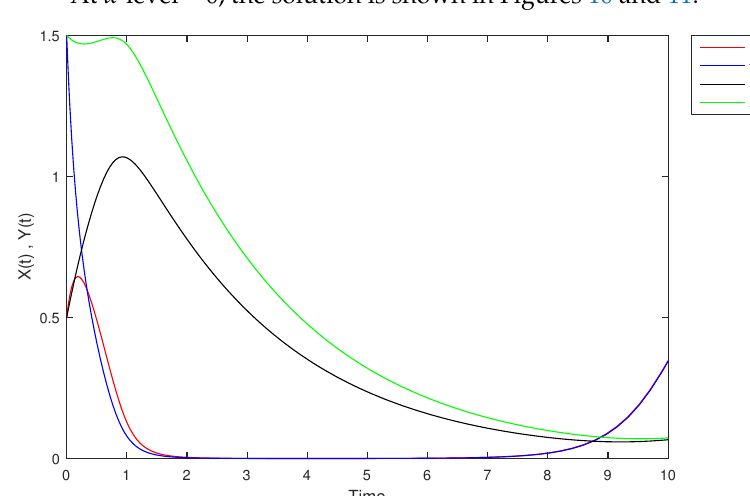
Figure 10. The solution of (7) at α = 0.0 for short time period.